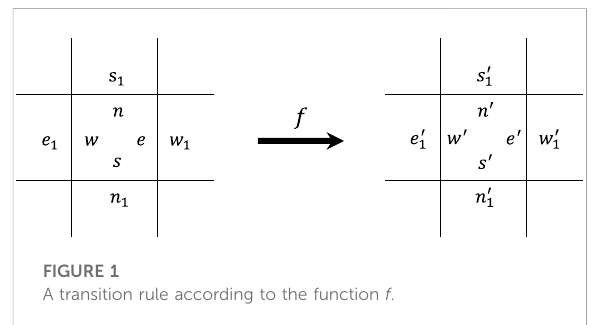
FIGURE 1 A transition rule according to the function f .